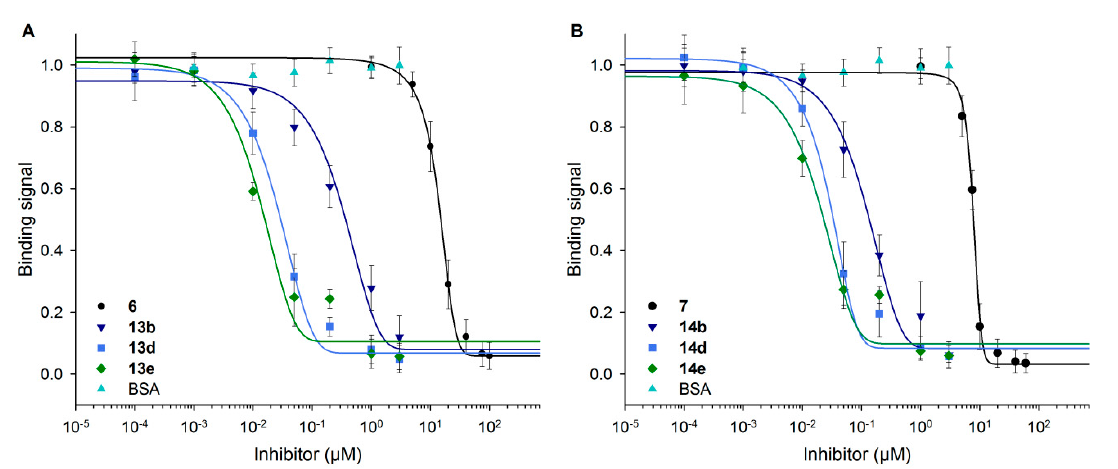
Figure 6. Inhibition of Gal-3 binding to ASF by BSA-based neo-glycoproteins. With increasing concentrations of 6-biotin LacNAc-LacNAc-conjugated ( A ) and 6-biotin LacdiNAc-LacNAc-conjugated BSA ( B ) as well as monovalent controls ( 6 and 7 ), Gal-3 binding signals on ASF decreased. The curves shifted to lower inhibitor concentrations with rising glycosylation